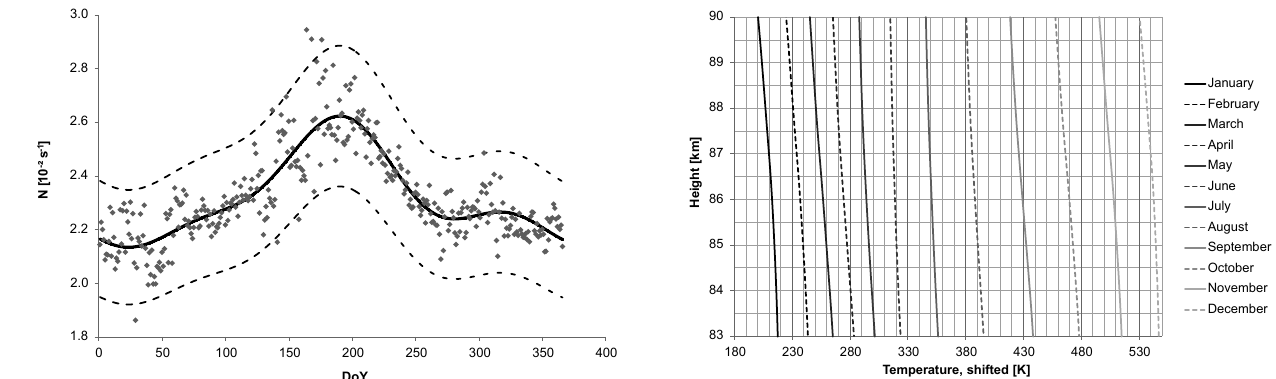
Figure 3. The superposition of the annual, semi-annual, and ter- annual oscillation (solid line) explains ca. 74% of the variability of the daily OH*-equivalent BV frequency values averaged over all years (diamonds). 97.8% of the data are located in a ± 10% interval (dashed lines) around the curve.